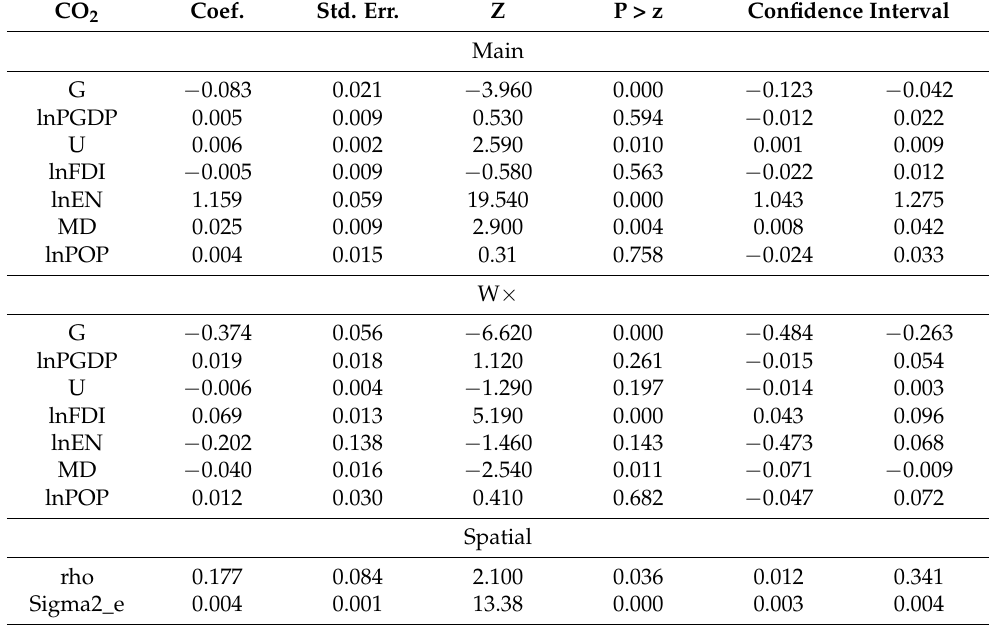
Table 6. Benchmark regression